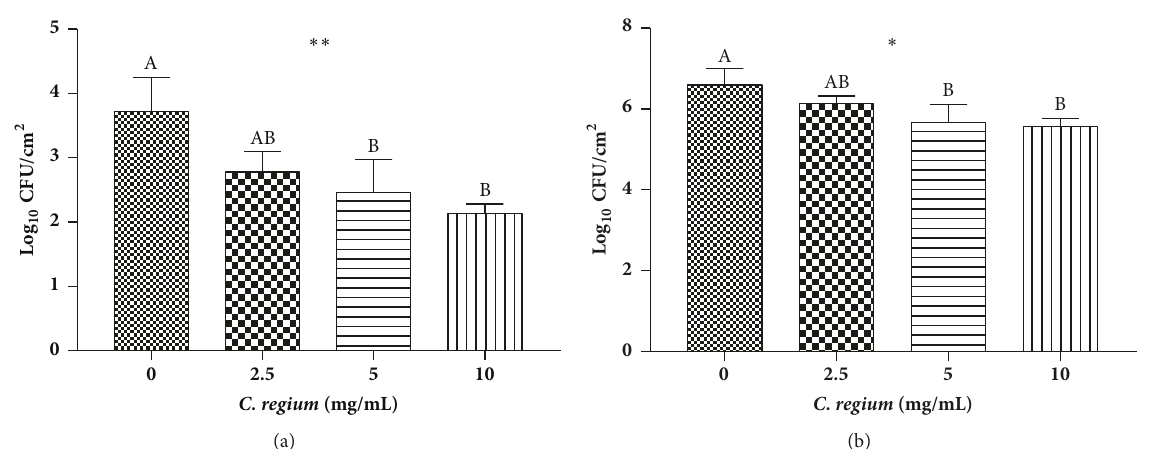
Figure 1: Activity of extract of C. regium against Cryptococcus gattii (ATCC 56990) biofilms. (a) Evaluation of ECR activity during biofilm formation by ANOVA and Tukey’s posttest. ∗∗ ( p < 0.05) indicates a significant difference. Different letters over each column indicate a significant difference between samples ( p < 0.05). (b) Evaluation of ECR activity on preformed biofilms by ANOVA and Tukey’s posttest. ∗ ( p < 0.05) indicates a significant difference. Different letters over each column indicate a significant difference between samples ( p < 0.05).